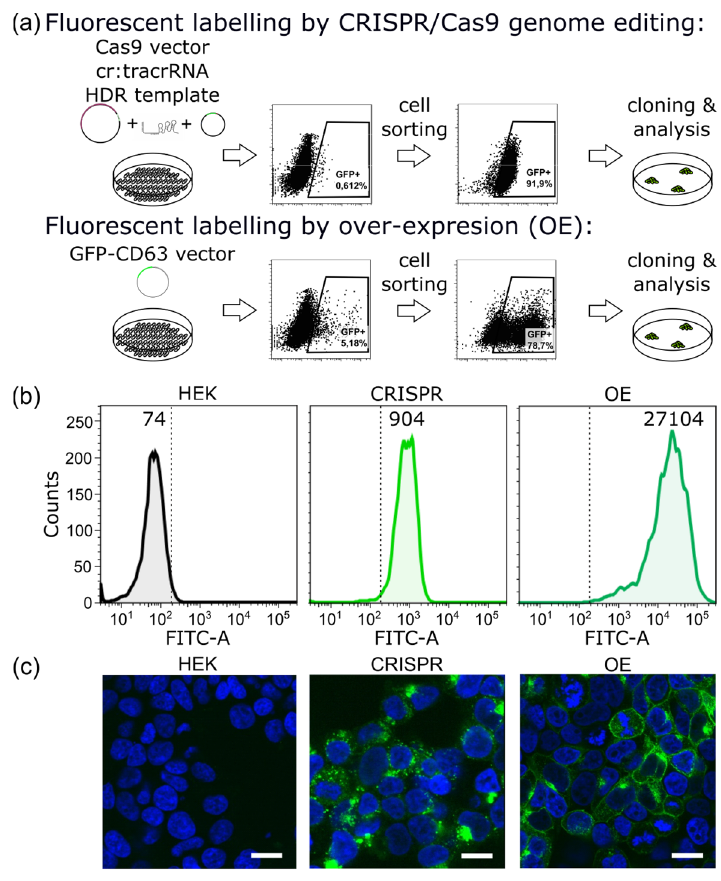
Figure 1. CRISPR/Cas9 approach and over-expression approach for fluorescent labeling of the EV marker CD63. ( a ) A schematic representation of the HEK293T cell transfections. The cells were either transfected with a Cas9 expression vector together with a guideRNA targeting exon 2 of CD63 and a homology-dependent repair (HDR) template encoding GFP in-frame with the CD63 coding sequence (upper panel) or with a vector encoding a GFP-CD63 fusion under the control of the CMV promoter (lower panel). After transfection, GFP fluorescence was detected in a subset of the cells, which were enriched by FACS sorting. In the next step, single-cell-derived clones were isolated and characterized by flow cytometry and immunofluorescence. ( b ) Flow cytometry analysis shows median fluorescence intensity (MFI) of GFP expression that was acquired in FITC-A channel. The parental HEK293T cells (HEK) are included as a negative control compared to the CRISPR/Cas9-edited GFP-CD63 HEK293T cells (CRISPR) and cells over-expressing GFP-CD63 (OE). ( c ) Untransfected HEK cells, CRISPR-, and OE-clones were seeded onto glass slides, fixed, counter-stained with DAPI, and analyzed with an Olympus FV10i confocal microscope. The CRISPR clone displays perinuclear GFP fluorescence, as expected for CD63, with minimal plasma membrane localization. In the OE clone, the plasma membrane localization of GFP-CD63 is clearly detected in a large fraction of the cells. The scale bar is 10 µ